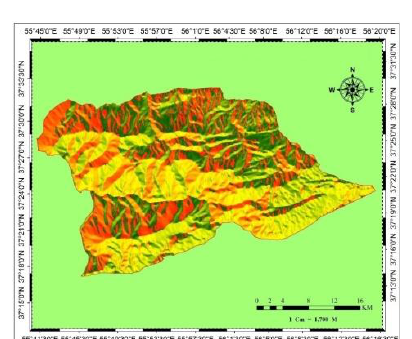
Figure 5. Mapping the direction of slope of the study